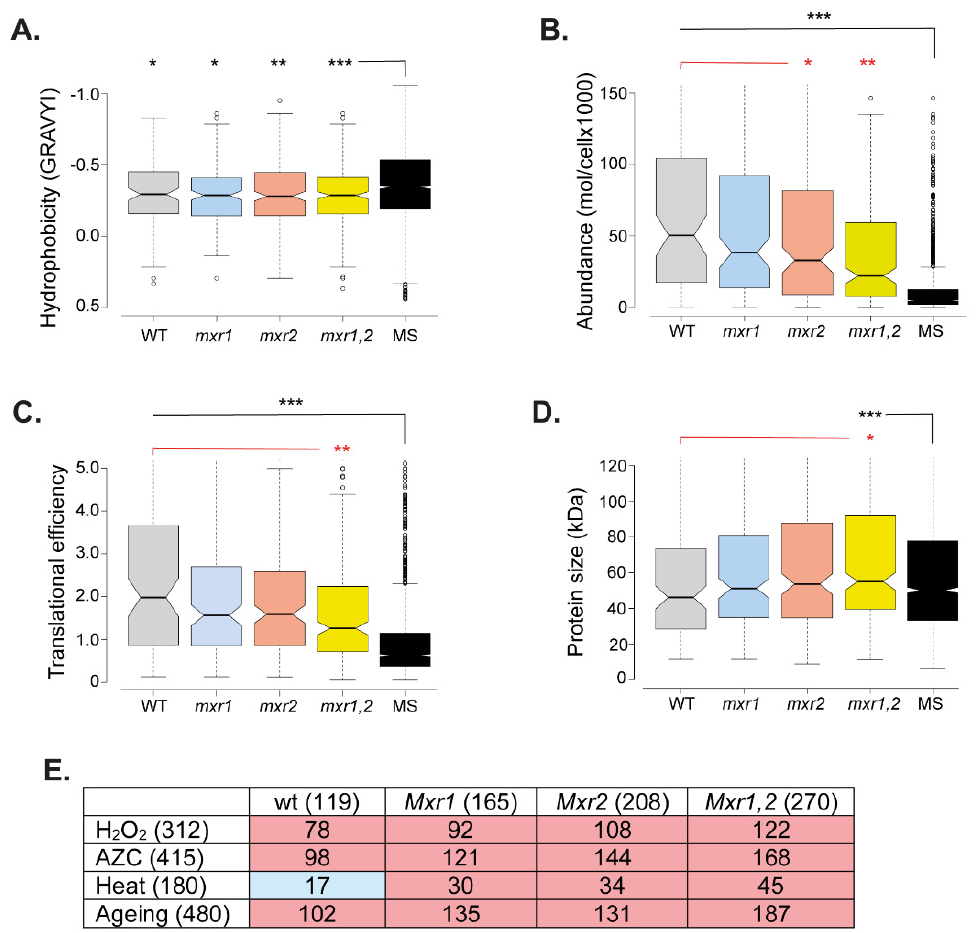
Figure 4. The localization and physicochemical properties of aggregated proteins are similar in wild- type and MXR mutants. Comparison of the aggregated proteins present in MXR mutants and the wild-type strain. Aggregated proteins were compared with a list of unaggregated proteins identified by mass spectrometry, referred to as the MS set. ( A ) Grand average of hydrophobicity (GRAVY). ( B ) The abundance of proteins (molecules/cell) in each set during non-stress conditions. ( C ) Translational efficiency (TE) expressed as the ratio of ribosome footprint density to mRNA density [61]. ( D ) Protein size (kDa). Mann–Whitney U-tests were used to assess the statistical significance of observed differences: * p < 0.05, ** p < 0.01, *** p < 0.001. ( E ) Comparison of the aggregated proteins present in the wild-type and MXR mutants with other datasets including proteins that aggregate during heat- shock [62], proteins that aggregate during AZC stress [59], proteins that aggregate during hydrogen peroxide stress [59], proteins that ag-gregate during postmitotic ageing in yeast [63]. Numbers in brackets indicate the size of each dataset. The significance of overlaps was determined by a hypergeometric test. Blue: p < 0.01, red: p <